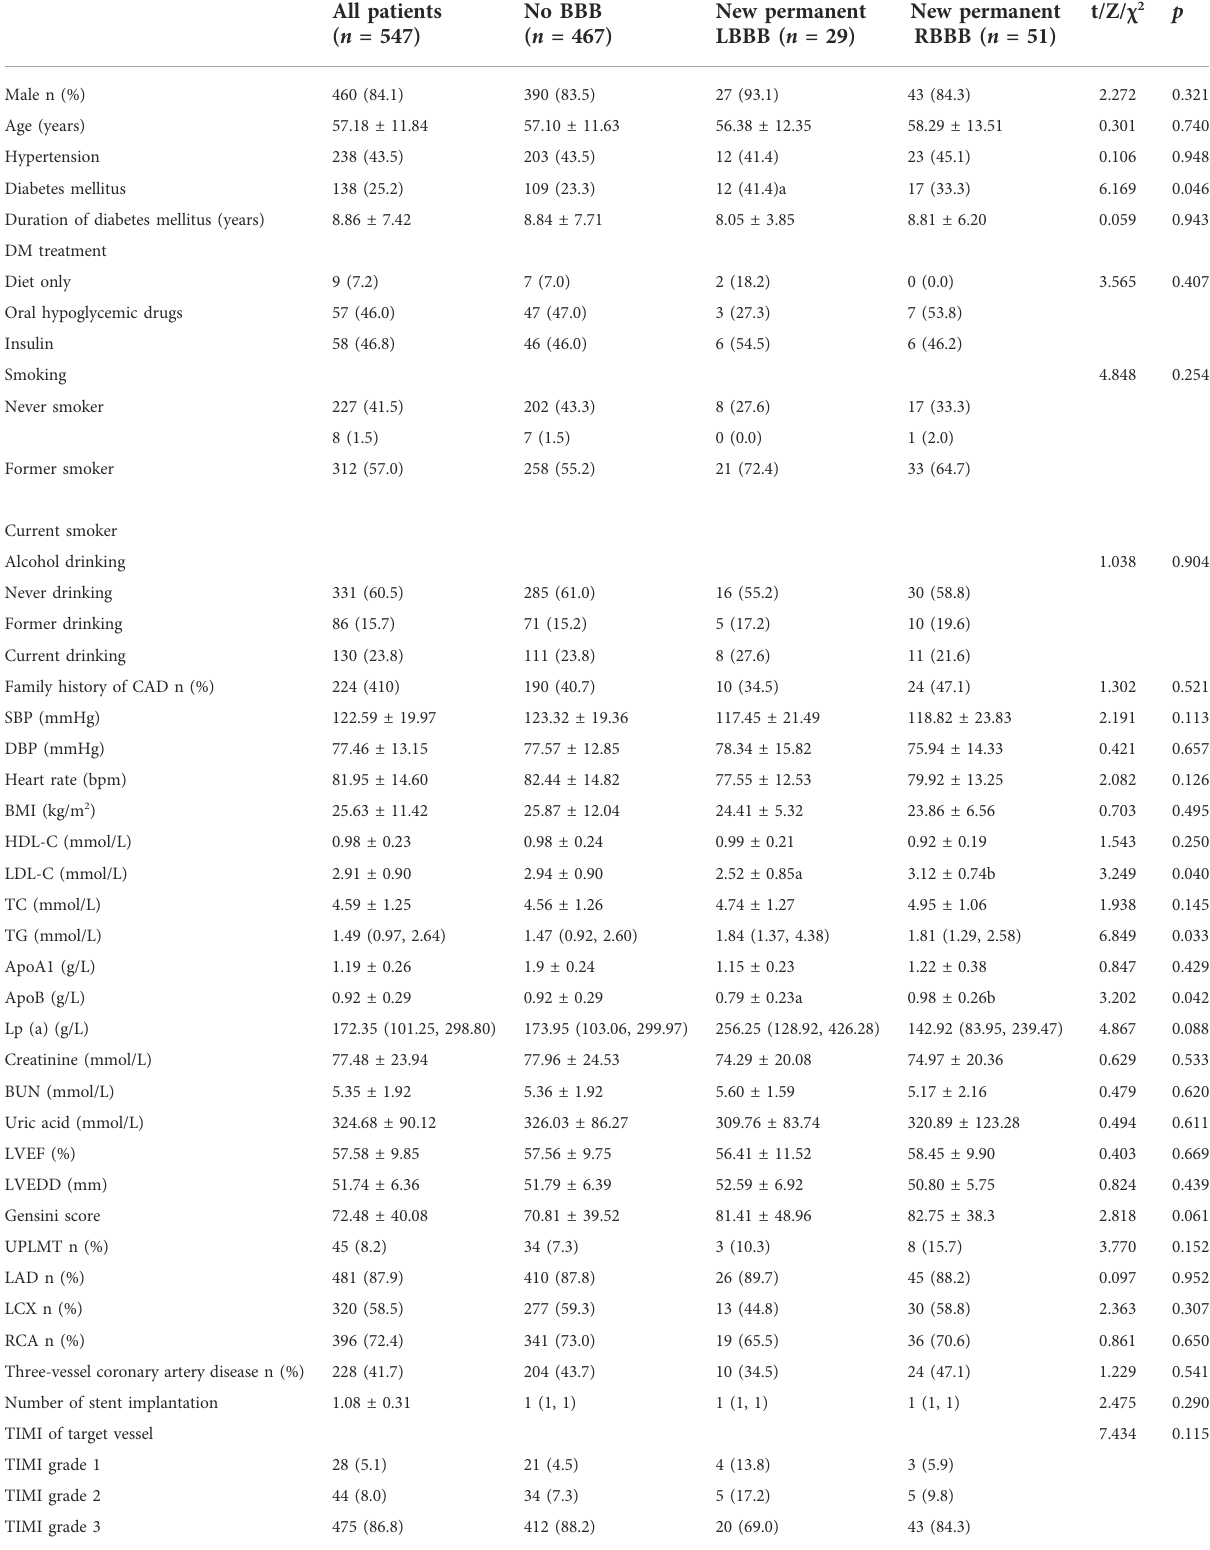
TABLE 1 Baseline